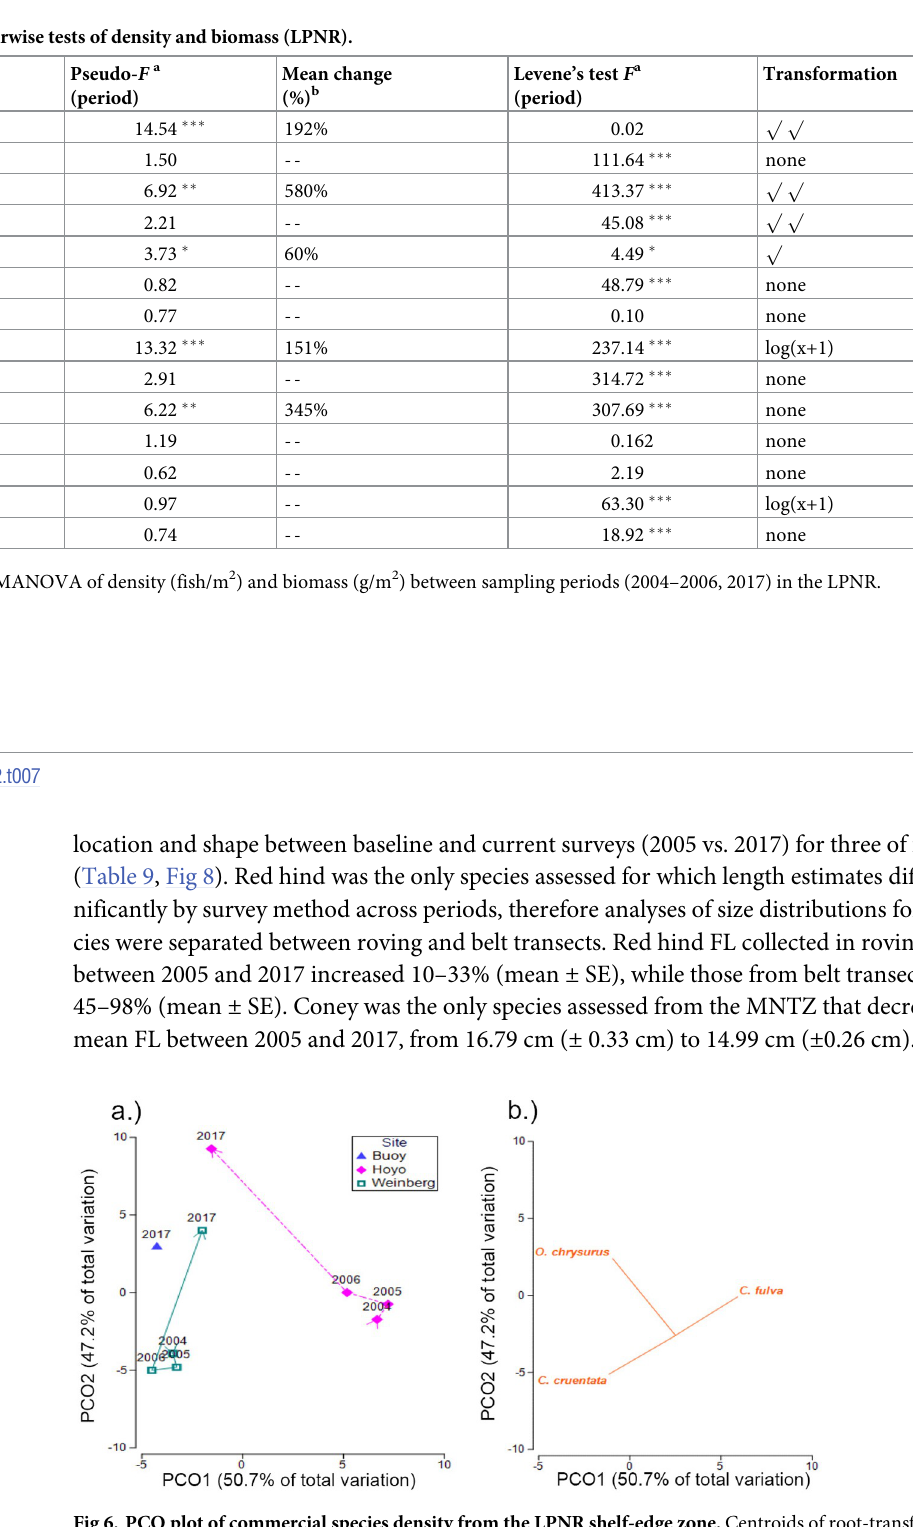
Fig 6. PCO plot of commercial species density from the LPNR shelf-edge zone. Centroids of root-transformed commercial species density from the LPNR by year from shelf-edge sites (a), with species response vectors indicating direction and magnitude of top species’ contributions to dissimilarities (Pearson > 0.2)